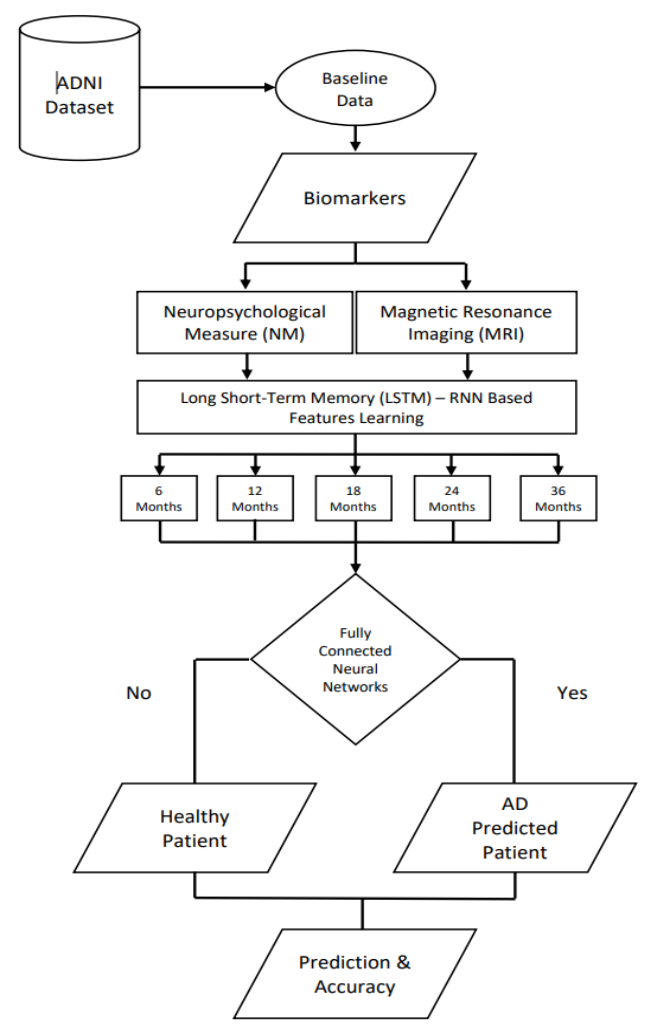
Figure 1. The proposed architecture of Alzheimer’s disease’s prediction.